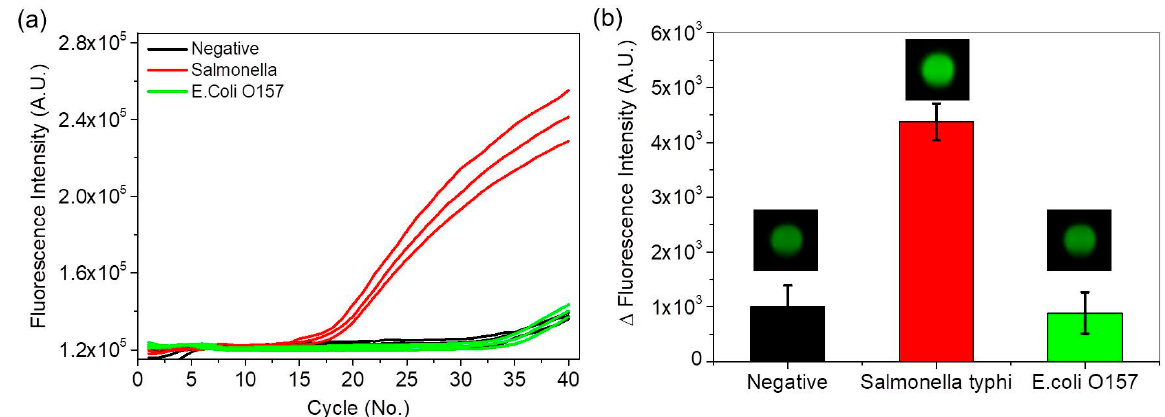
Figure 7. ( a ) Real-time PCR curves for Salmonella (red lines), E. coli O157 (green lines), and negative samples (black lines) using the commercial PCR device, and ( b ) variations in fluorescence intensity and images during the same Salmonella PCR assay using the automated fast PCR